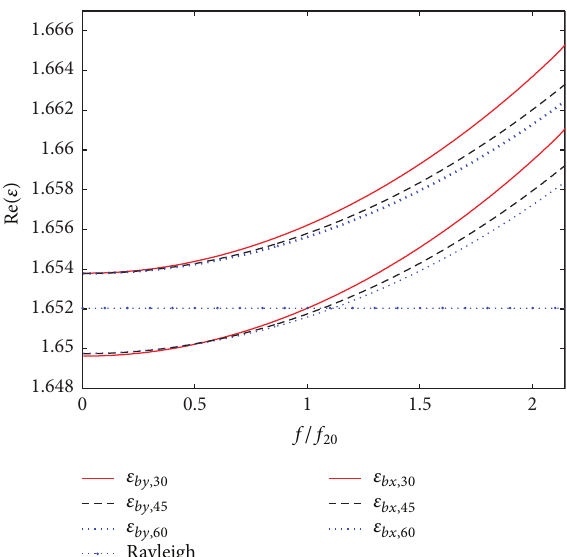
Figure 11: Retrieved 𝜀 𝑥 and 𝜀 𝑦 for different 𝜃 0 when 𝜀 𝑦 (𝜃 0 ) of the A- (𝜃 ) of the H-model. The subscript numerals denote model equals 𝜀 0 eff the incidence